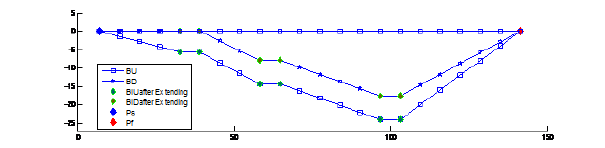
Fig. 8 The final results of upper and lower limits between two path